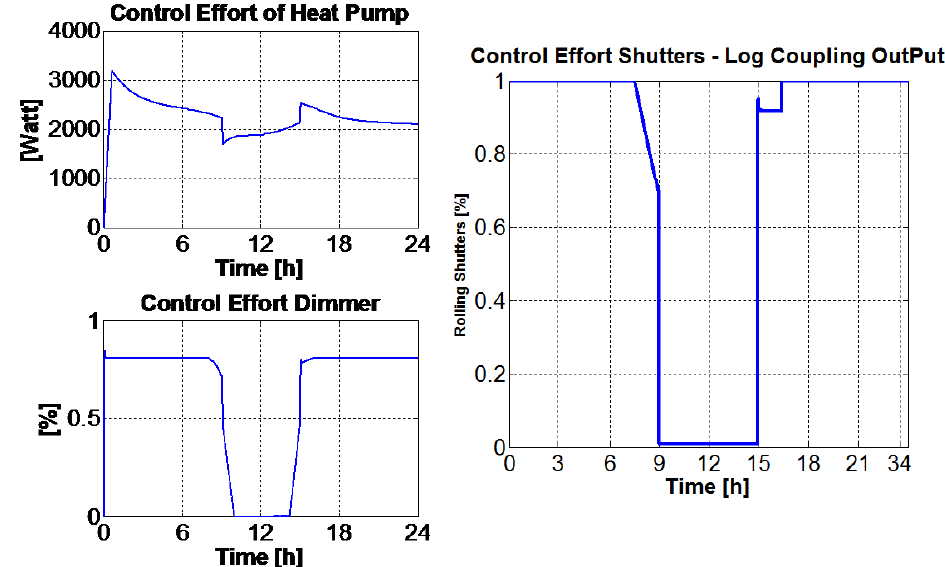
Figure 27. Control results (first scenario, initial control system, Energy Saving policy): MVs (heat pump, dimmer, and rolling shutters).